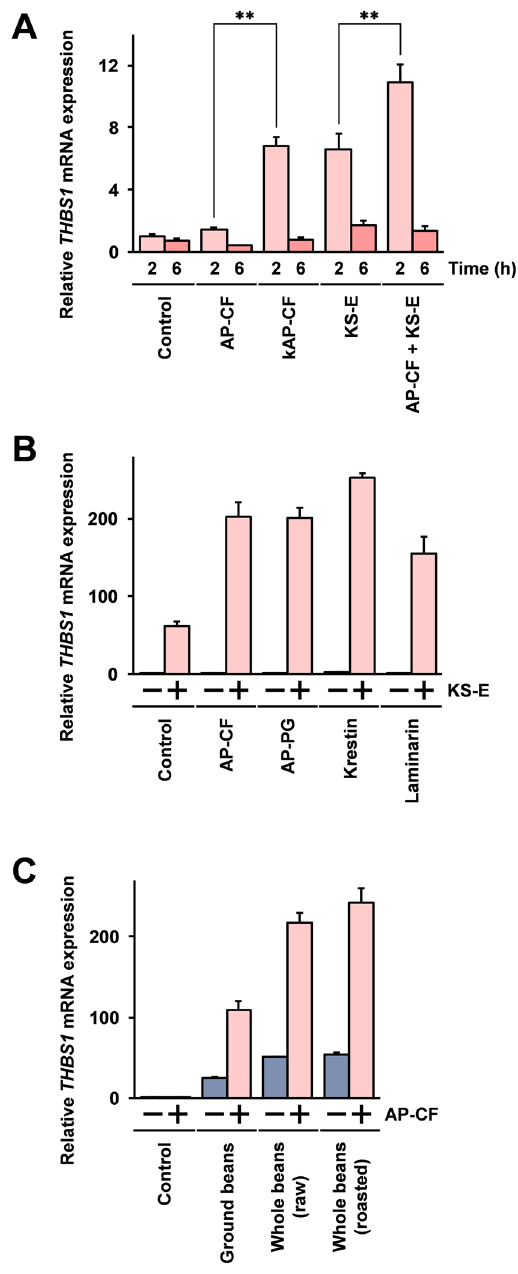
Figure 2. β -glucan is involved in the enhancement of THBS1 expression after stimulation with KS-E. ( A ) THP-1 cells were stimulated with conventional AP-CF or AP-CF made using ground powder of Kurosengoku soybeans (kAP-CF) as a nitrogen source, at the concentration of 100 μ g/ml β -glucan, or the cells were stimulated with KS-E at 20-fold dilution. The cells were harvested at the time points indicated in the figure, and the THBS1 mRNA expressions in the cells were measured using the real-time RT-PCR method. ( B ) Mono Mac 6 cells were stimulated with AP-CF, AP-PG, Krestin, or laminarin at concentrations of 100 μ g/ml β -glucan, with or without 20-fold dilution of KS-E. ( C ) Mono Mac cells were stimulated with a 20-fold dilution of KS-E from ground beans, whole raw beans, or whole roasted beans, with or without AP-CF at a concentration of 100 μ g/ml β -glucan. After 2 hours, the cells were harvested, and then the total RNA prepared from the cells was subjected to real-time RT-PCR analysis. The data are represented as relative values compared with the mRNA expression in unstimulated control cells after normalization with the GAPDH mRNA expression. Error bars indicate standard deviations calculated by three independent